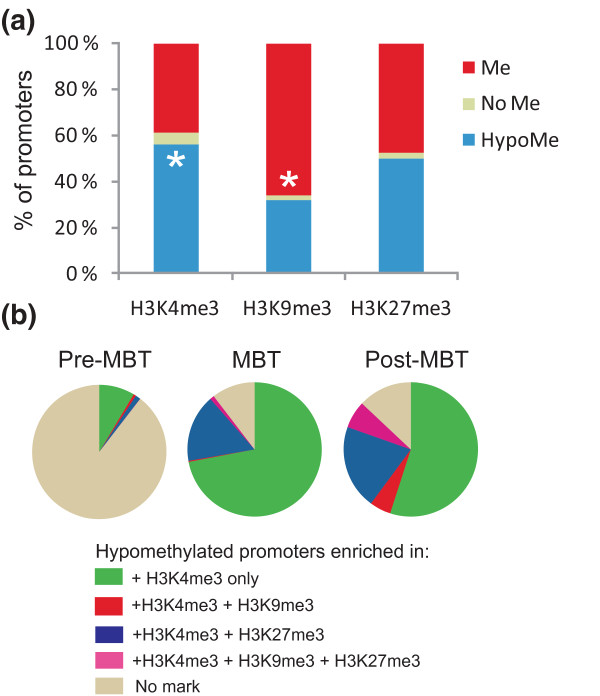
Enrichment of hypomethylated and methylated genes in, respectively, H3K4me3 and H3K9me3. (a) Post-MBT proportions of H3K4me3, H3K9me3 and H3K27me3 enrichment on methylated promoters, hypomethylated promoters and promoters with genome-average methylation (that is, neither statistically hypomethylated nor methylated; 'No Me'). *P < 10-4 relative to the opposite methylation state (Fisher). Histone methylation data are from our laboratory [13]. (b) Proportions of hypomethylated promoters not marked by H3K4me3 (or any other histone modification), or co-enriched in H3K4me3 only or with a repressive mark (H3K9me3, or H3K27me3, or both).